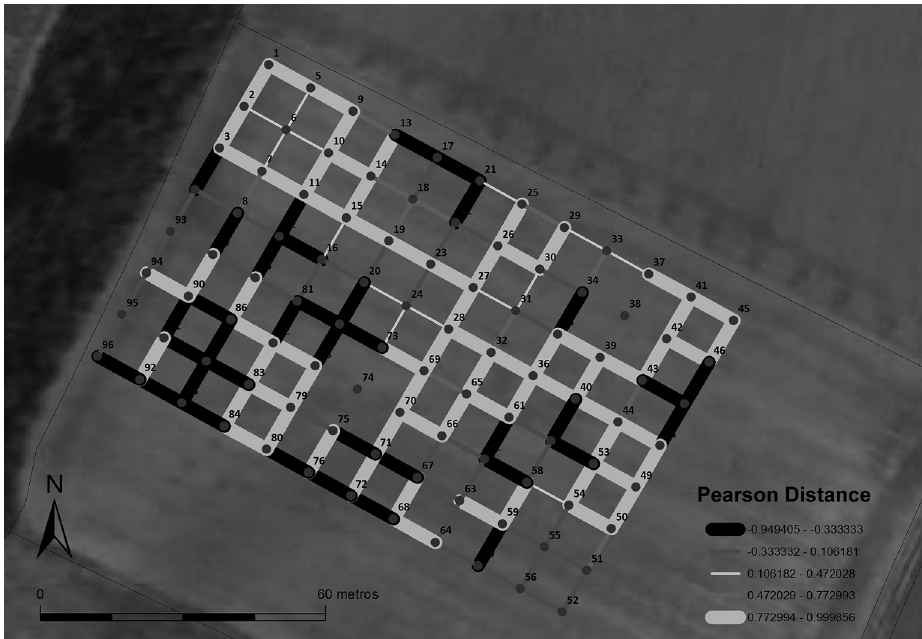
Figure 2: Pearson correlation expressed as distance in a cartogram to express assemblage variability in Granjería